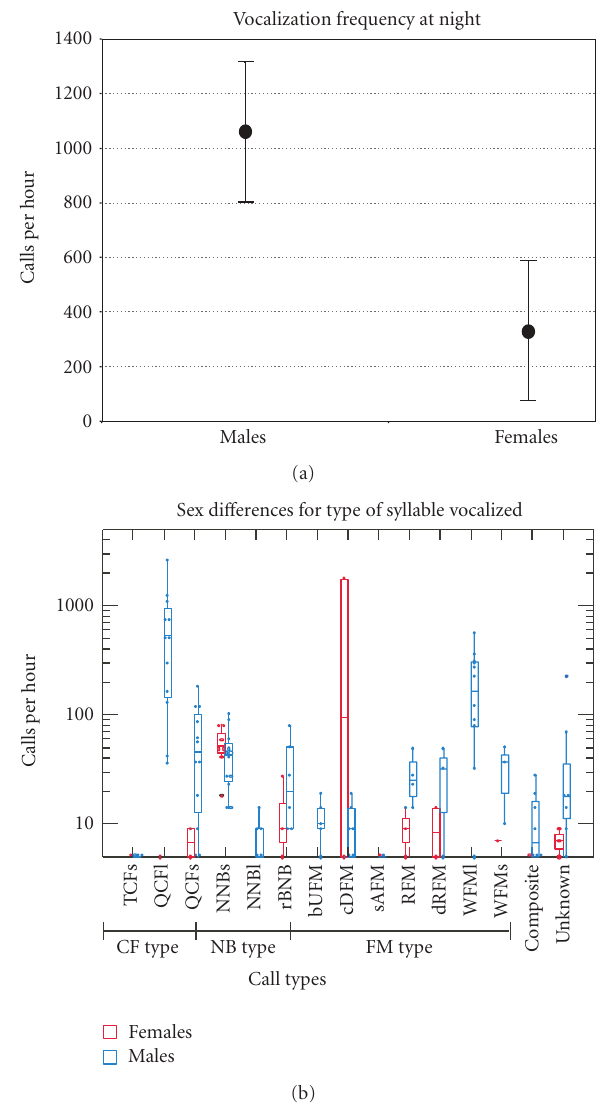
Figure 8: (a) Mean (solid circles) and standard deviation bars for frequency (number of calls per hour) of call production in males versus females. (b) Side-by-side box plots overlaid on density plots indicating the interquartile range (box edges) and the mean (dividing line within box) frequency of vocalization of di ff erent simple syllabic call types (CF, NB, and FM) in females (red) versus males (blue). Overlapping points, indicating the same value, are jittered. Composites are made of combinations of simple syllables. Whiskers at each end of the box indicate the 10th and 90th percentiles, and asterisks indicate data points outside this range. “Unknown” refers to call types that could not be easily classified. Other abbreviations are as in Figure